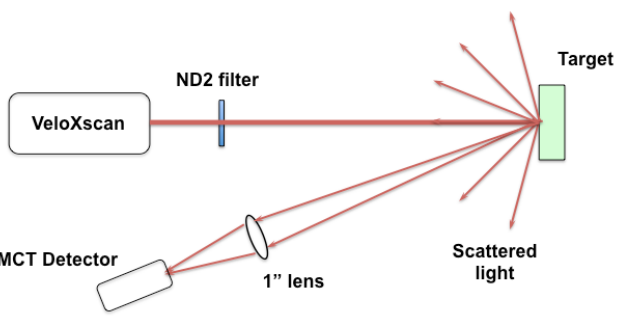
Figure 9. Schematic of an AOM-controlled QCL setup for short-range standoff detection.